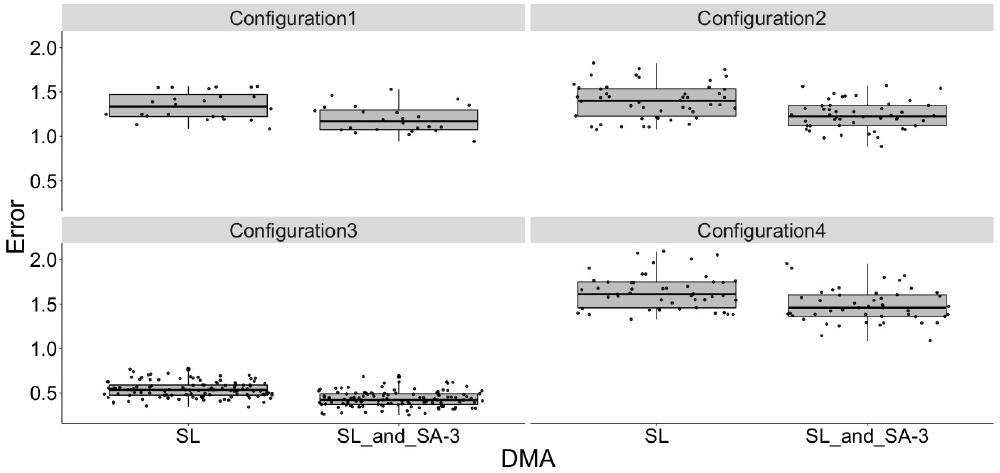
Figure 8. Box-plots of the associated errors by ANN configuration.